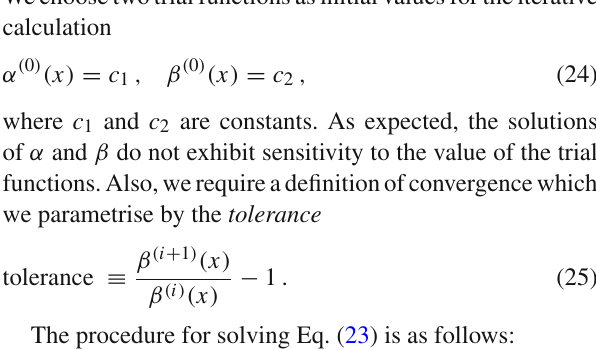
G Λ 2 ≈ 1 implies A (cid:3) 30. Therefore new particle content